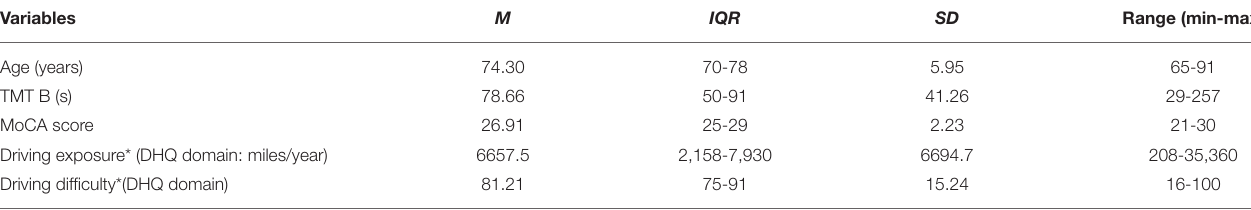
TABLE 2 | Indicators of continuous independent variables: Age, cognition, and self-reported driving habits ( N = 104). Variables